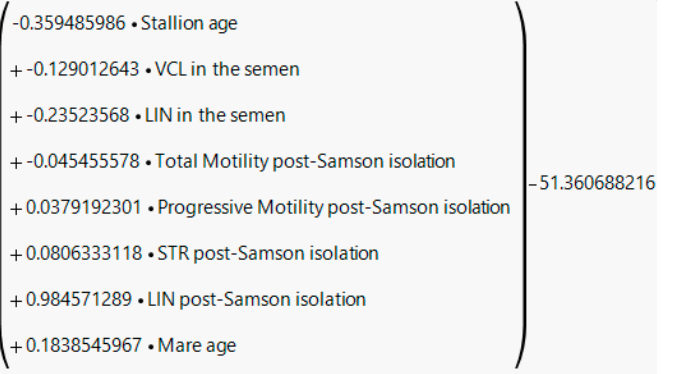
Figure A7. Equation optimized for stallion 1 from the post-chilled data set: predictive accuracy of 80%.